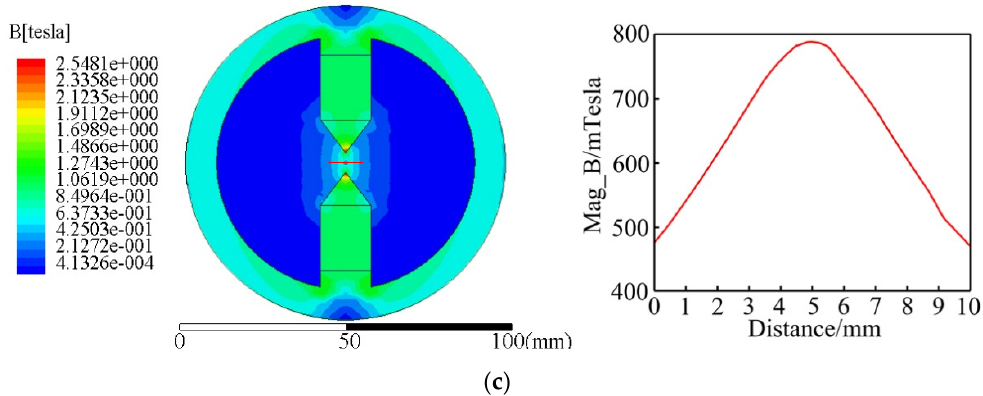
Figure 2. Simulation of the magnetic field intensity and the magnetic induction line: ( a ) 0° taper, distribution diagram; ( b ) 25° taper, distribution diagram; ( c ) 37° taper, distribution diagram.